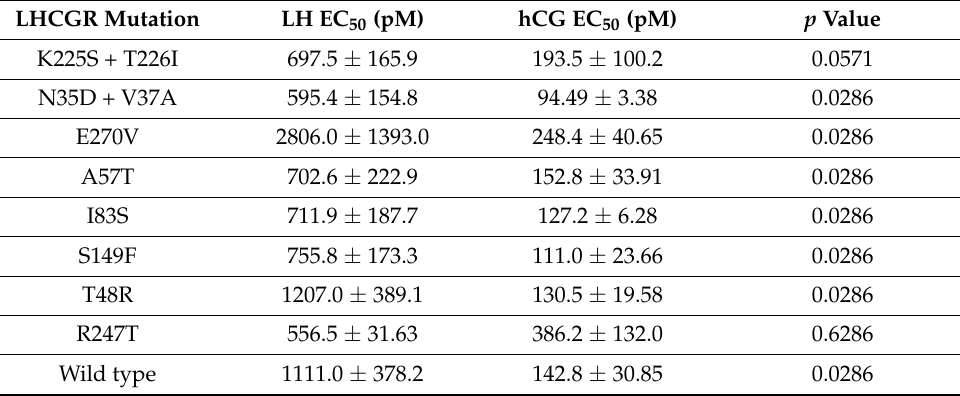
Figure 2. LH- and hCG-induced cAMP response in HEK293 cells overexpressing ( a ) wild type LHCGR, ( b ) the K225S + T226I or ( c ) the R247T mutants. HEK293 cells were transiently transfected with mutant or wild type LHCGR- and CAMYEL-expressing plasmids. Bioluminescence resonance energy transfer (BRET) changes were measured after treating cells 30 min with increasing concentrations of LH or hCG (1 pM–100 nM range) in the presence of 3-isobutil-1-methylxanthine (IBMX). Moreover, 50 µ M forskolin served as a positive control. Data were interpolated by non-linear regression and expressed as percentage of the maximal response (means ± SEM; n = 4). Table 2. LH and hCG EC 50 extrapolated from dose-response curves after cAMP